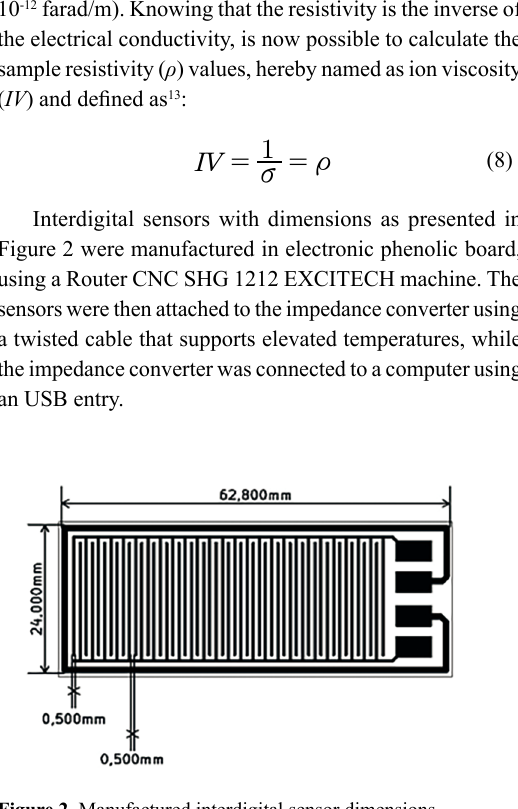
Figure 2. Manufactured interdigital sensor dimensions.